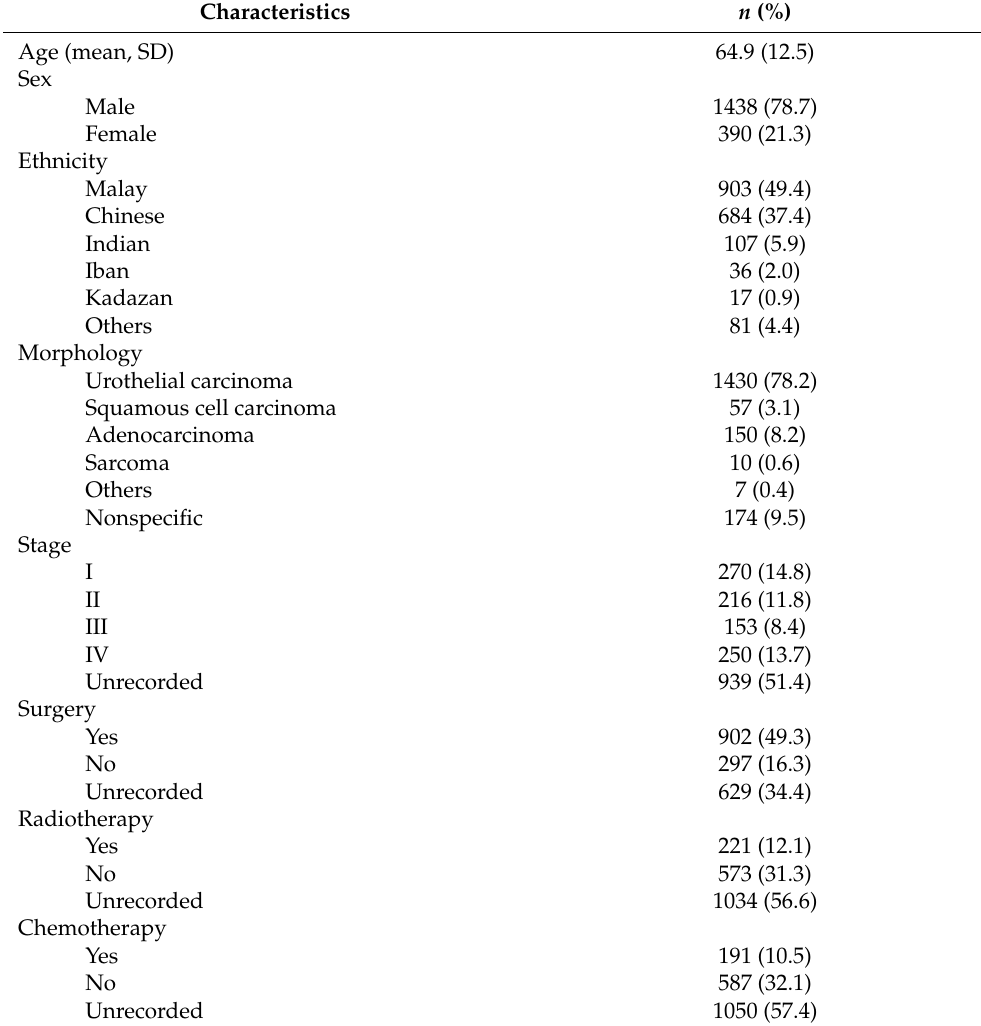
Table 1. Bladder cancer patients’ characteristics ( n =